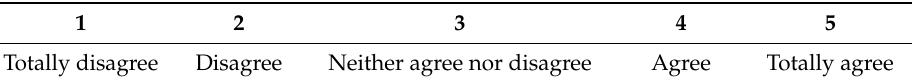
Table 2. The scale used to answer the